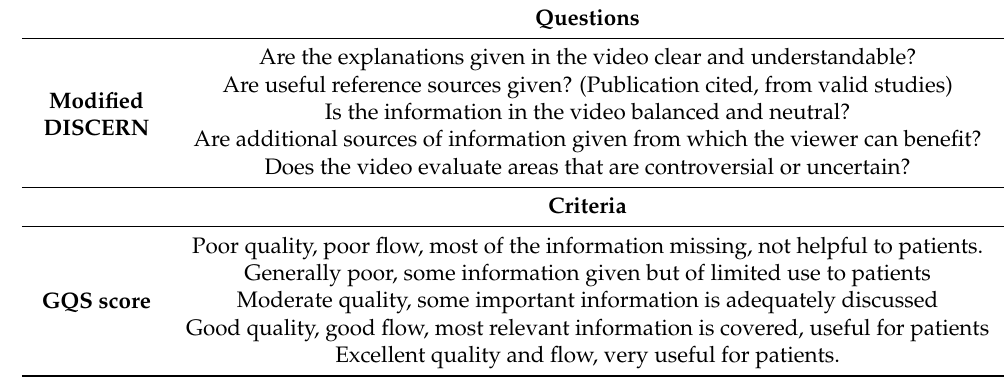
Table 1. Description of the questions that make up the reliability (DISCERN) and global quality (GQS) of YouTube